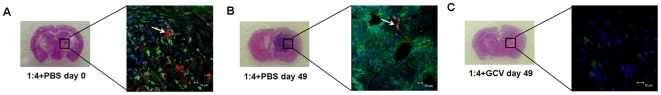
Effect of GCV on fluorescent Rluc-R-tTK-hAMSC at tumor implantation sites.Left, representative images of HE stained brain sections; Right, representative fluorescence confocal microscope images showing implanted red fluorescent cells Rluc-R-tTK-hAMSC (arrow), and Pluc-G-U87 cells (green). (A) Control mouse (1∶4+PBS) at T = 0, (B) control mouse (1∶4+PBS) at T = 49, (C) treated mouse (1∶4+GCV) at day 49. Blue, Hoescht stained nuclei. Scale bar = 10 µm.